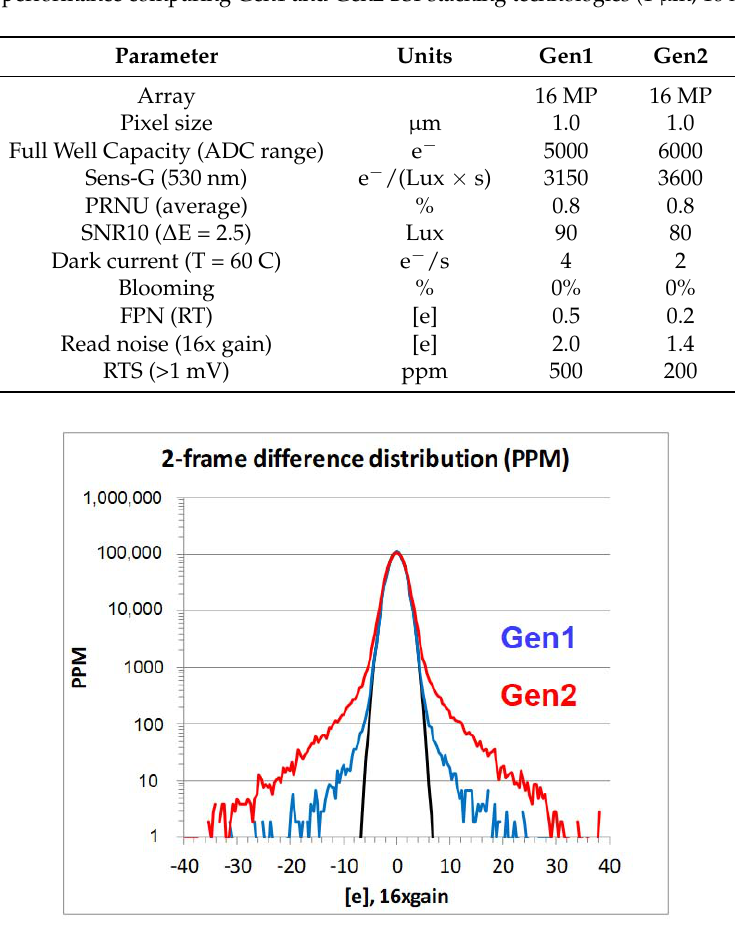
Figure 8. Two-frame difference image, noise histogram comparing the 1 µm, 16 MP images sensors that use the Gen1 and Gen2 technology.